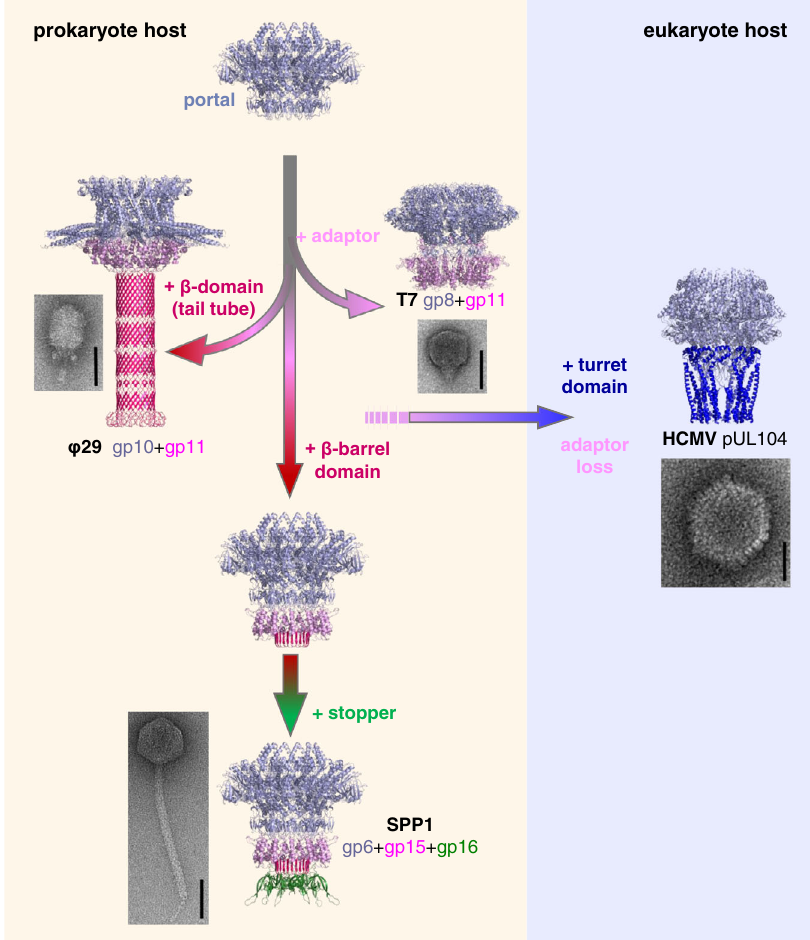
Fig.6|Evolutionarydivergenceoftheprokaryotictailedviruses-herpesviruses lineage at the portal vertex. The portal protein (in grey-blue) is conserved in all viruses ofthe lineage. The adaptor protein (light magenta) thatbinds to the portal clip of prokaryotic viruses has various structural features in the region distal from the portal. They de fi ne two evolutionarydivision pointsfor viruseswithshorttails, typi fi edbyphagesT7and φ 29,fromthephageswithlongtails.Adaptorproteinsof phageswithlongtailsencompassa β -barrel(magenta)forbindingstopperproteins (ingreen).Additionofaturretdomain(inblue)totheportalandlossoftheadaptor proteininherpesviruses marks theirdivergencefrom prokaryote viruses.Domains